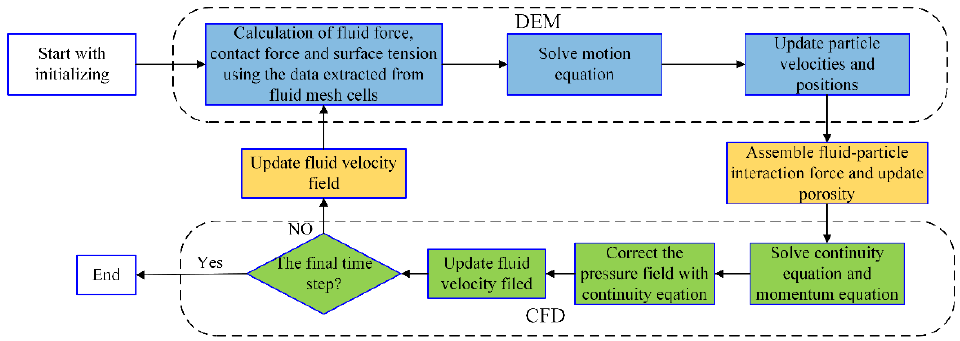
Figure 2. Computing cycle of CFD – DEM model.